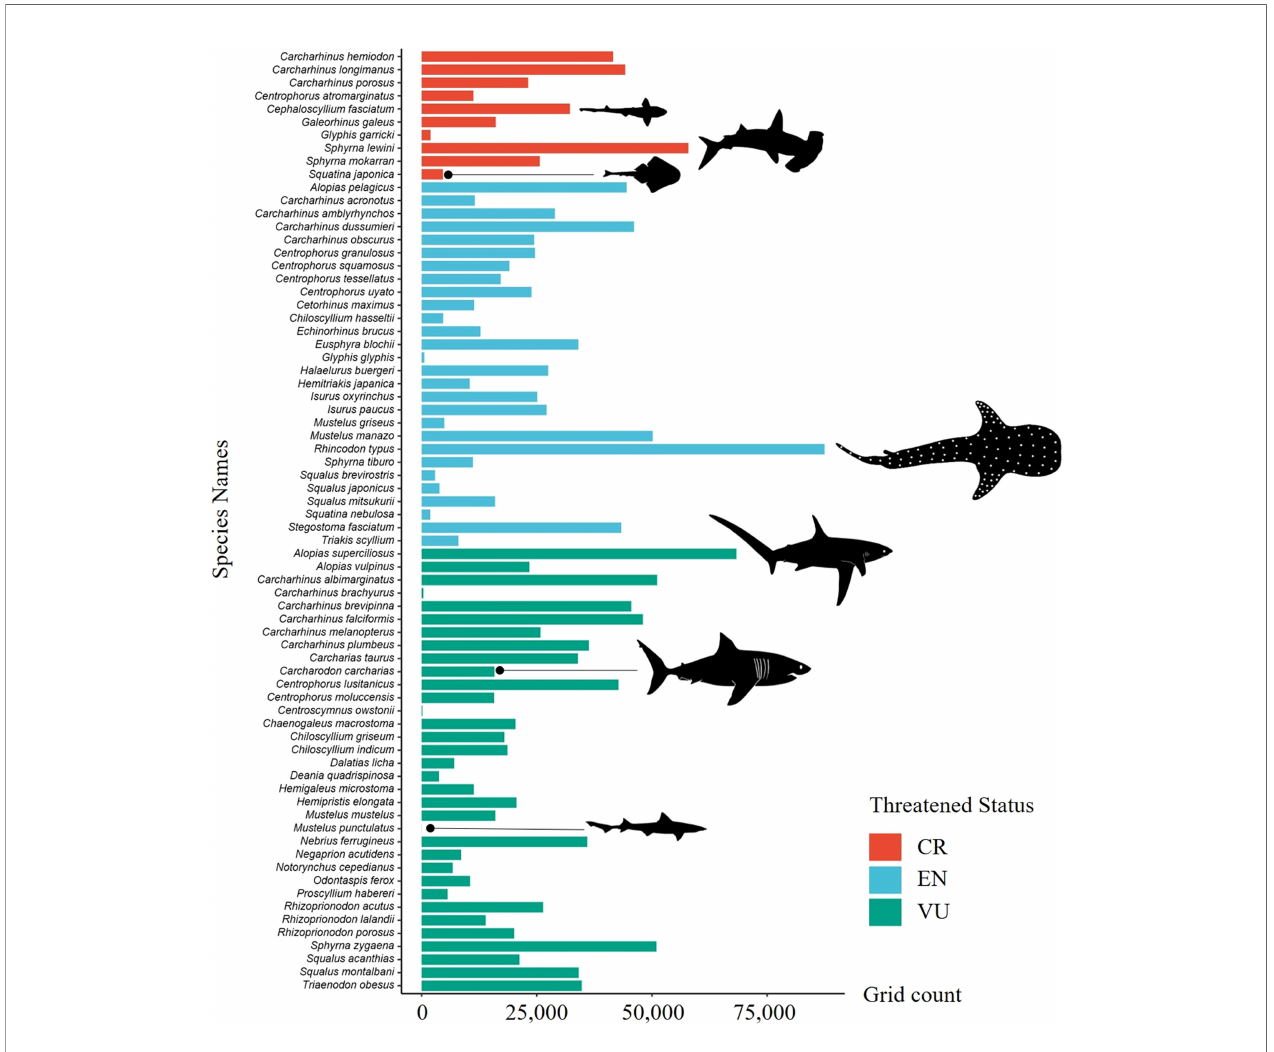
FIGURE 6 | Potential distribution range of ETP